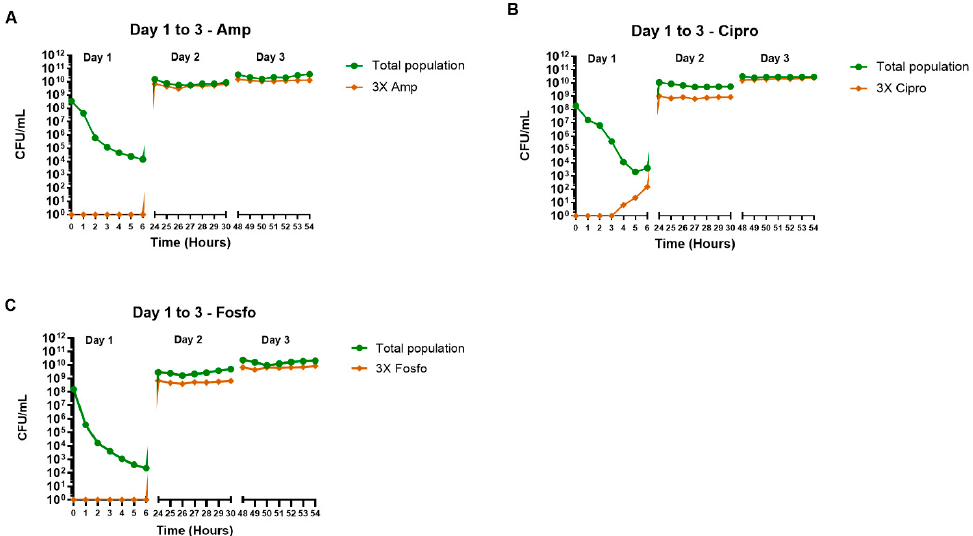
Figure 5. The effect of ampicillin ( A ), ciprofloxacin ( B ) and fosfomycin ( C ) single antibiotic therapy regimens on the density of the total and 3× antibiotic-resistant subpopulations in the hollow fiber infection model. The samples were collected up to 6 h post-antibiotic treatment over 3 days. The 3× antibiotic-resistant subpopulations were grown on agar containing the respective antibiotic minimum inhibitory concentration (MIC) levels. Data shown are from single independent hollow fiber runs.